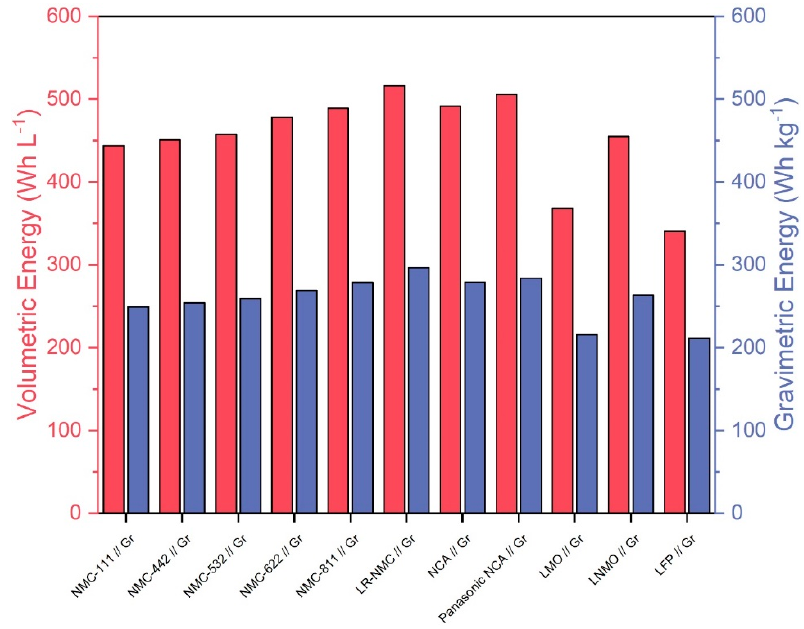
Figure 2. Volumetric energy in (Wh L − 1 ) based on used material volume and gravimetric energy in (Wh kg − 1 ) of the 10 considered cell chemistries plus the Panasonic NCA Use Case.